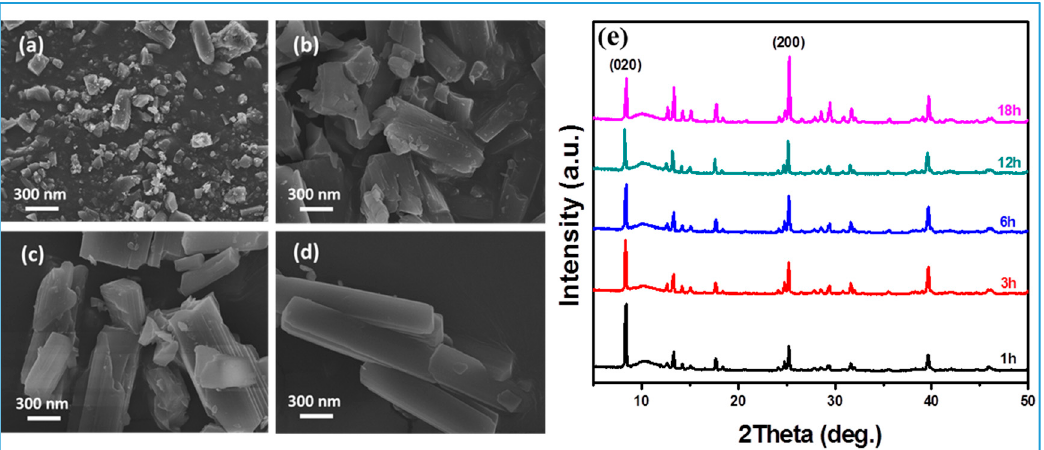
Figure 2. SEM images of Ca-MOF 24h-10 with different reaction times: ( a ) 10 min; ( b ) 1 h; ( c ) 6 h; ( d ) 18 h; ( e ) the corresponding XRD.